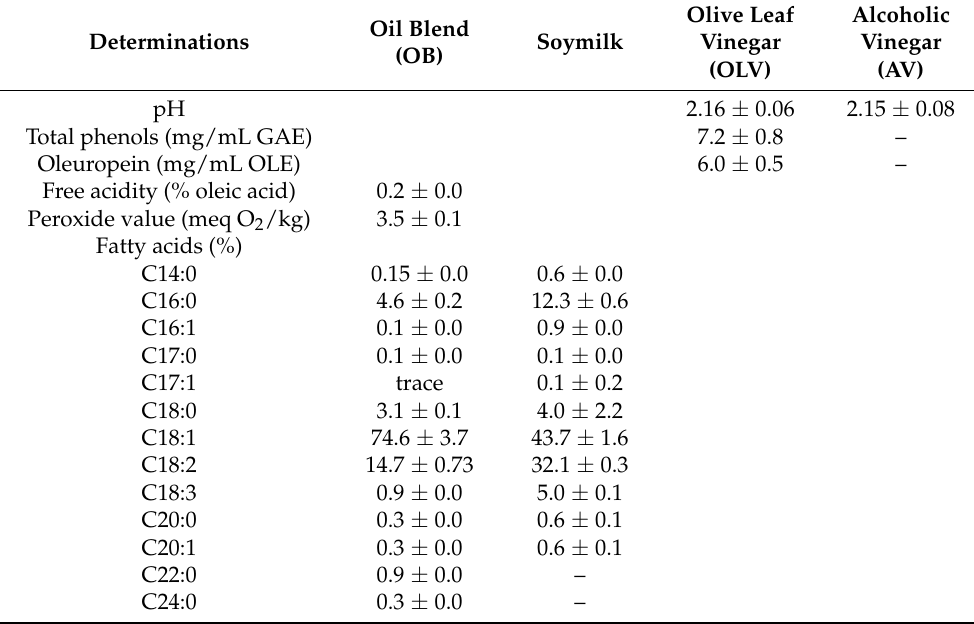
Table 1. Determined analytical characteristics of the mayonnaise ingredients. The data are the means ± standard deviation of triplicate measures. Olive Oil Blend Determinations Soymilk (OB)